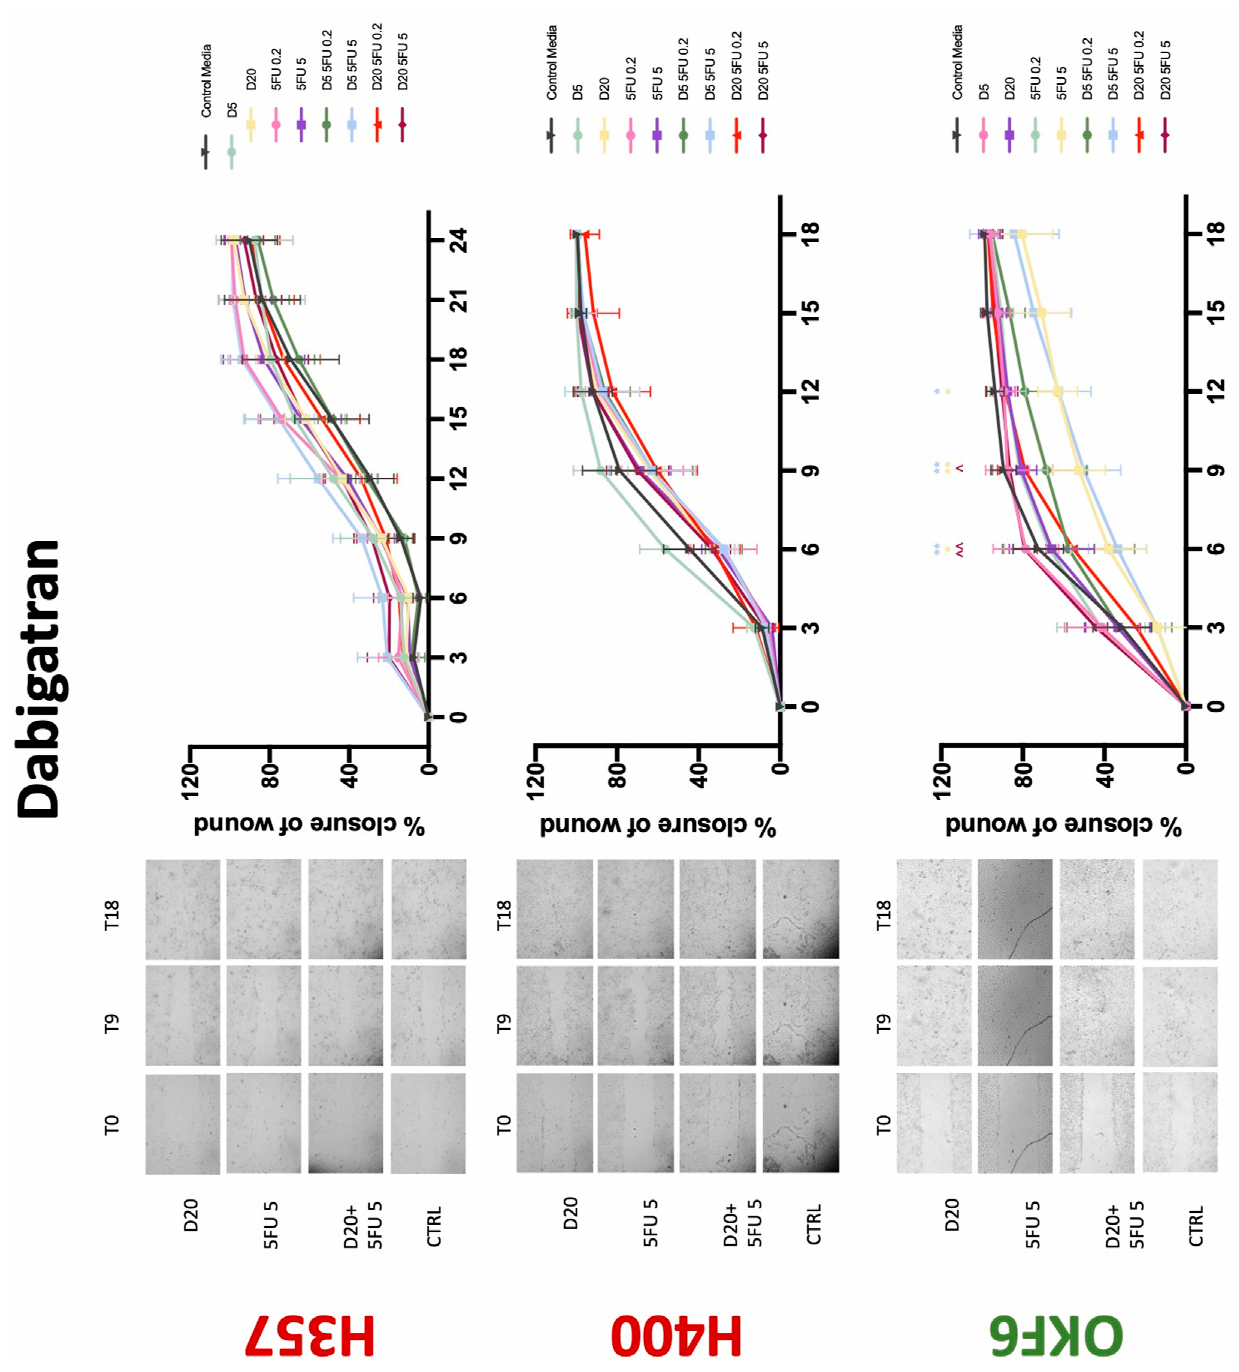
Figure 9. Wound healing assay . The effect of (5/20 µ M) dabigatran and (0.2/5 µ g/mL) 5-FU on H357, H400, and OKF6 cell migration. Data are represented as mean ± SD. Statistical significance is given as follows: * p < 0.05, ** p < 0.01; (*) compared to control group; ^^ p < 0.01; (^) compared to respective 5-FU groups.